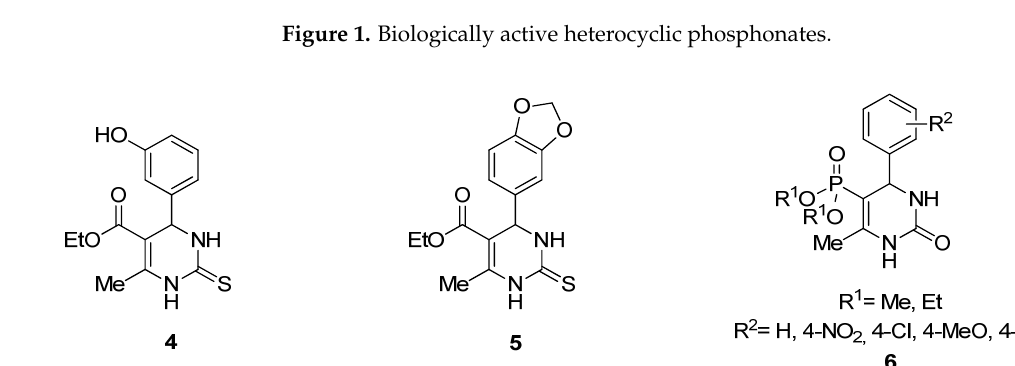
Figure 1. Biologically active heterocyclic phosphonates.